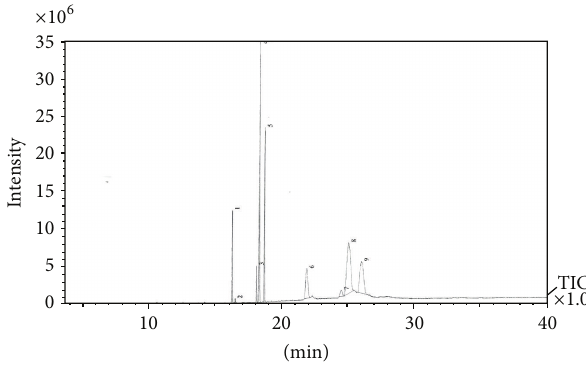
Figure 1: A gas chromatography-mass spectrometry chromatogram peak profile of Jatropha curcas leaf